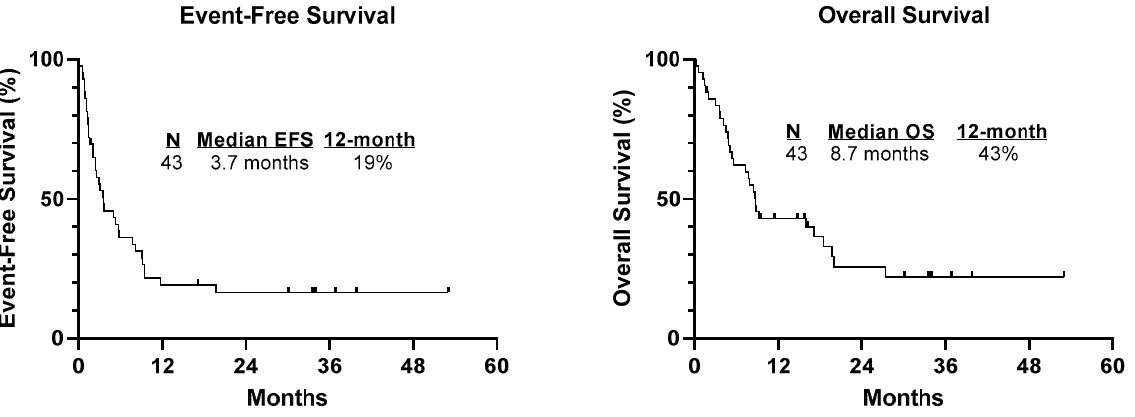
Figure 2. Survival curves. Legend: Kaplan–Meier curves showing EFS and OS from the start of venetoclax therapy.